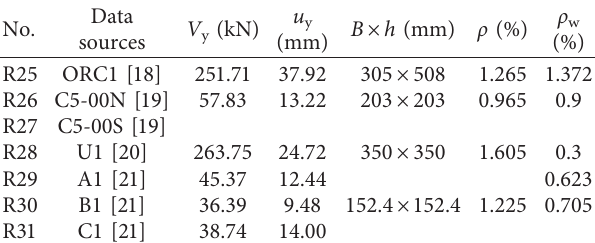
Figure 14: Prediction procedure of D Table 3: The properties of 7 specimens in the PEER